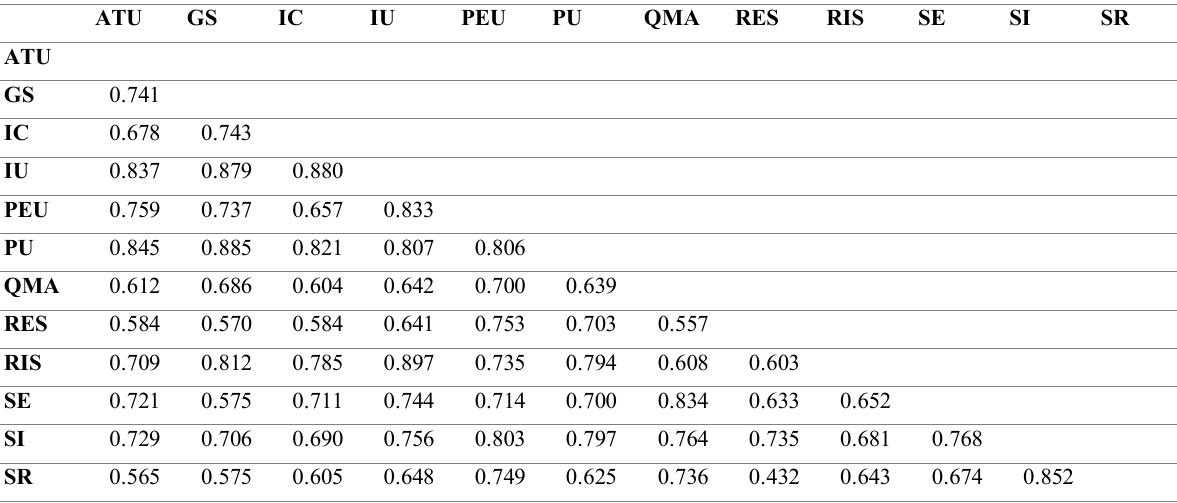
Table 4: Discriminant Validity (Heterotrait-Monotrait Ratio